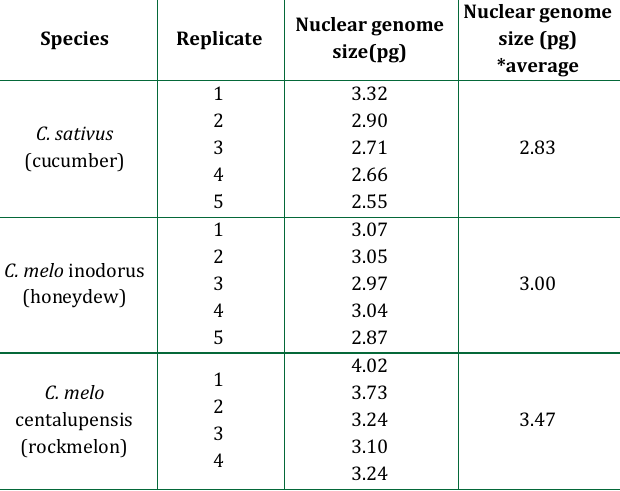
Table 1: Genome size of C. sativus , C. melo inodorus and C.